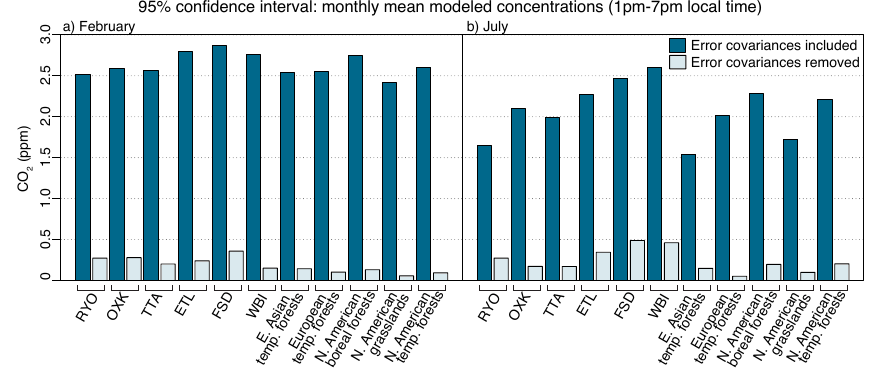
Figure 4. The uncertainties in monthly-averaged, afternoon atmospheric CO 2 (Sects. 2.4, 3.3) at a selection of representative, global CO 2 observation sites. Panels (a) and (b) show the results at each site for February and July 2009, respectively. Dark blue bars indicate the difference between the top and bottom of the 95% confidence interval when we include error covariances. The light blue bars indicate the results when we remove these covariances in atmospheric transport errors. Observation sites in the figure include Ryori, Japan (RYO); Ochsenkopf, Germany (OXK); Talk Tower Angus, UK (TTA); East Trout Lake, Saskatchewan, Canada (ETL); Fraserdale, Ontario, Canada (FSD); and West Branch, Iowa, USA (WBI). For more information on these observation sites, refer to Table S1 in the Supplement. Uncertainty in monthly mean modeled concentrations as a percentage of the CO 2 increment from surface fluxes a) February